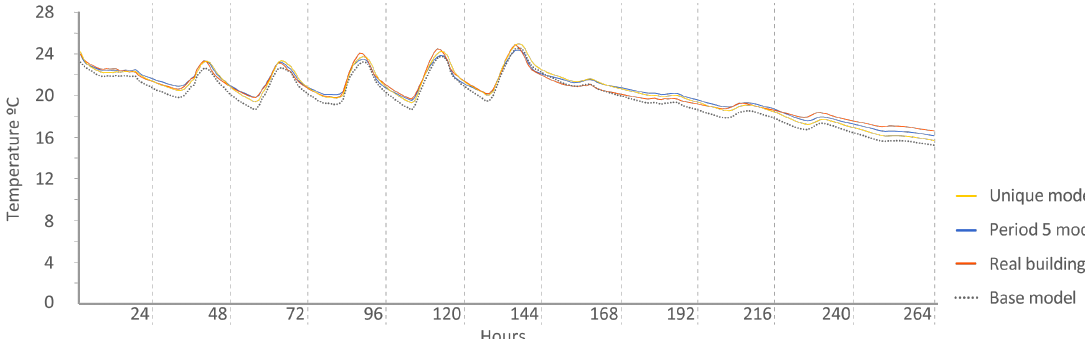
Figure 22. Temperature in house O5, Period 5 (free oscillation). Period 5 model: CV(RMSE): 1.57%, NMBE: − 0.11%, and R 2 : 97.52%. Base model: CV(RMSE): 3.64%, NMBE: 3.06%, and R 2 : 97.75%. Unique model: CV(RMSE): 2.12%, NMBE: 0.36%, and R 2 :